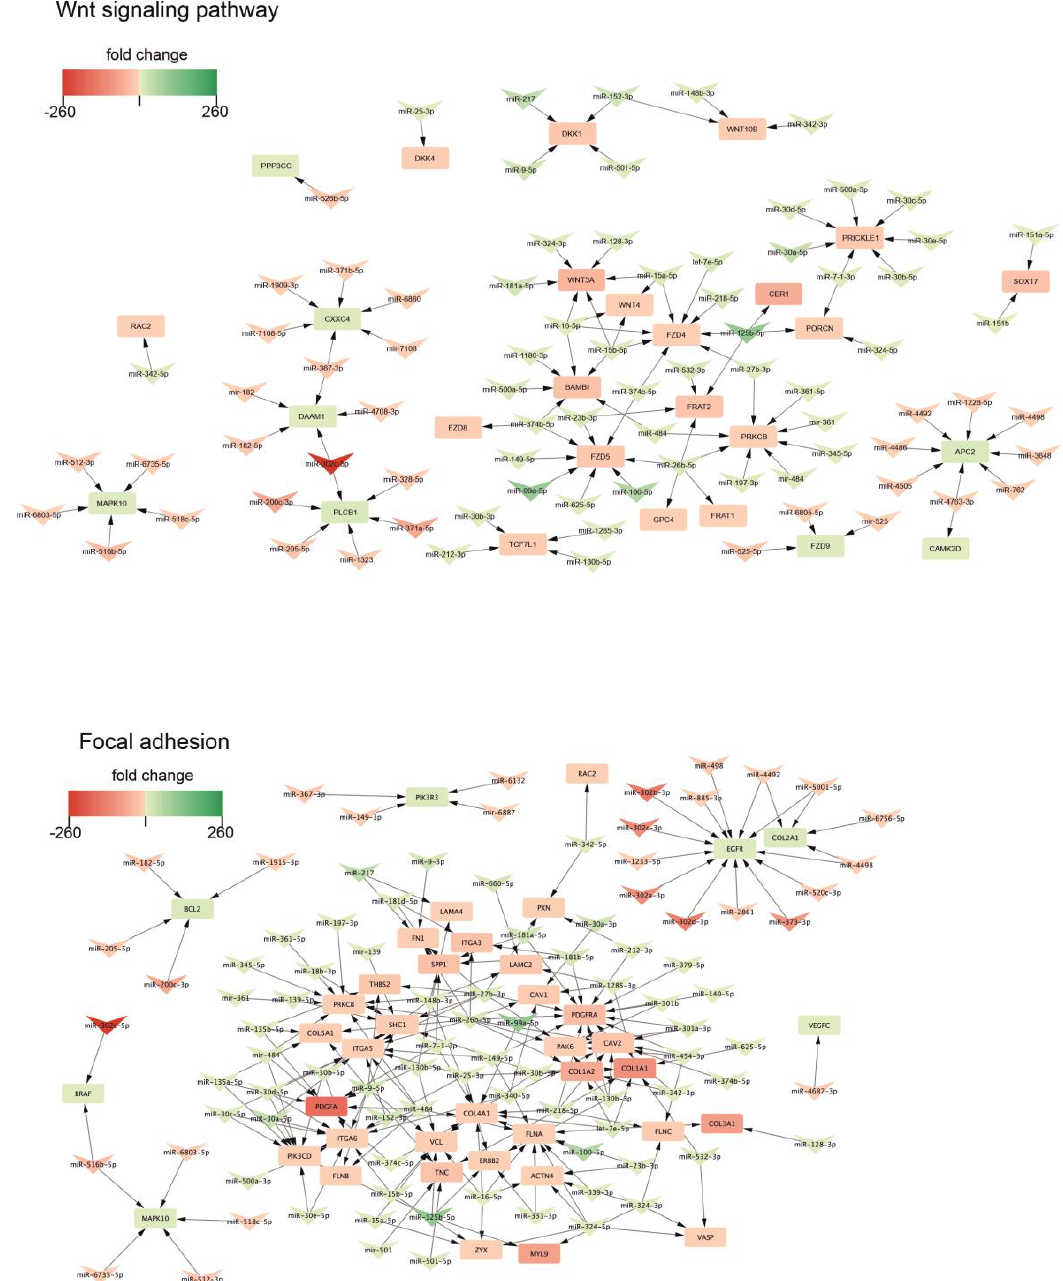
Figure 6. WNT signaling and focal adhesion are involved in the regulation of neural differentiation. Arrowheads represent differentially expressed miRNAs, and squares — negatively regulated genes.